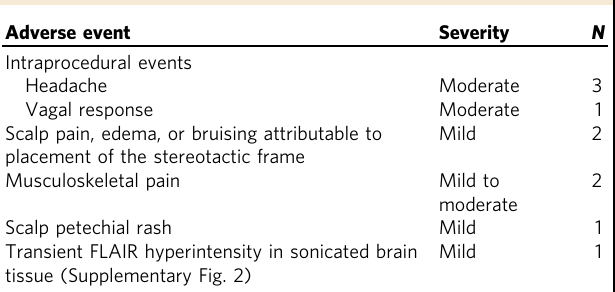
Table 2 Procedure-related adverse events Adverse